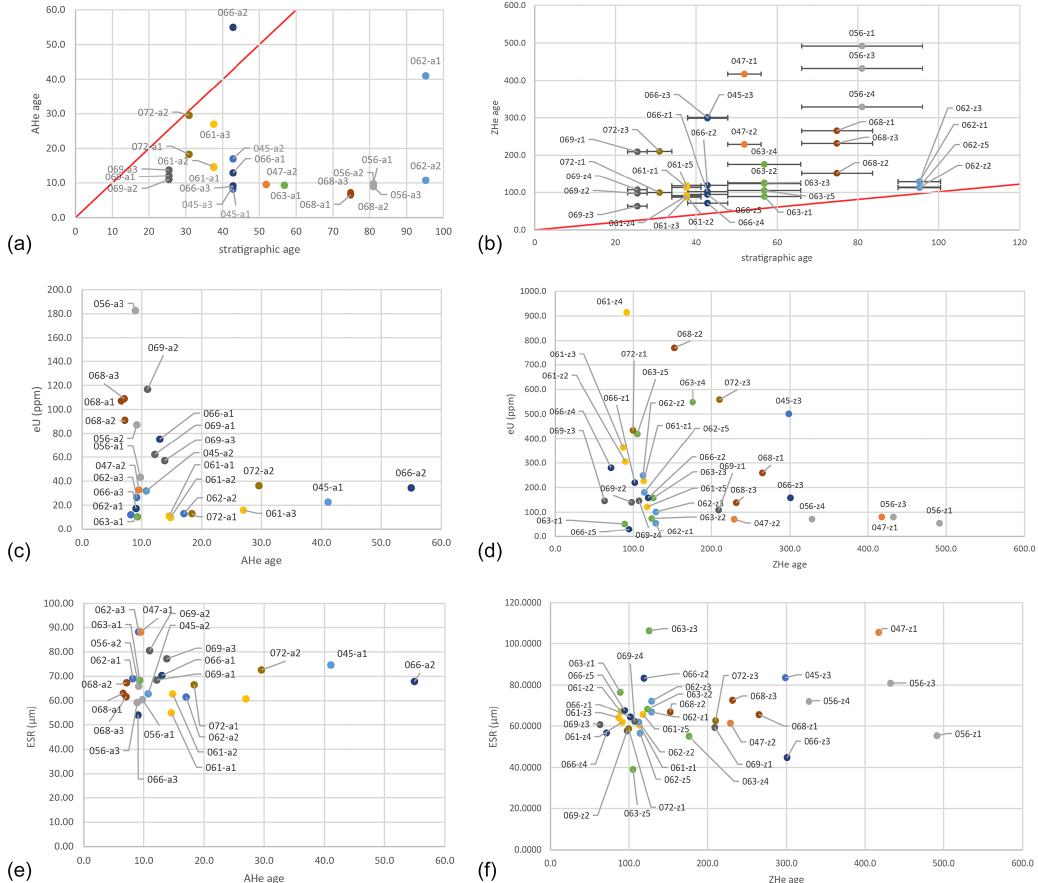
Figure A1. The circle color refers to a sample, and the same color code is applied for all graphs. (a) Graph of AHe single-grain ages compared to the stratigraphic age. CAR19-066_a2 is the only non-reset grain. (b) ZHe single-grain age compared to the stratigraphic age. ZHe dates are non-reset and mark the sediment source age of exhumation. (c) AHe single-grain age versus eU (ppm) content. (d) ZHe single-grain age versus eU (ppm) content. (e) AHe single-grain age versus ESR (equivalent sphere radius, in µm). (f) ZHe single-grain age versus ESR.